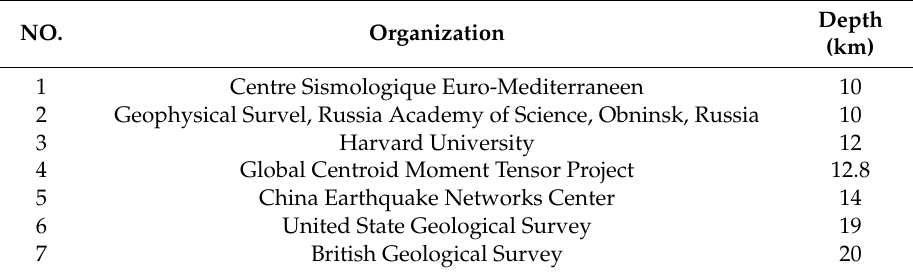
Table 2. Focal depth of di ff erent